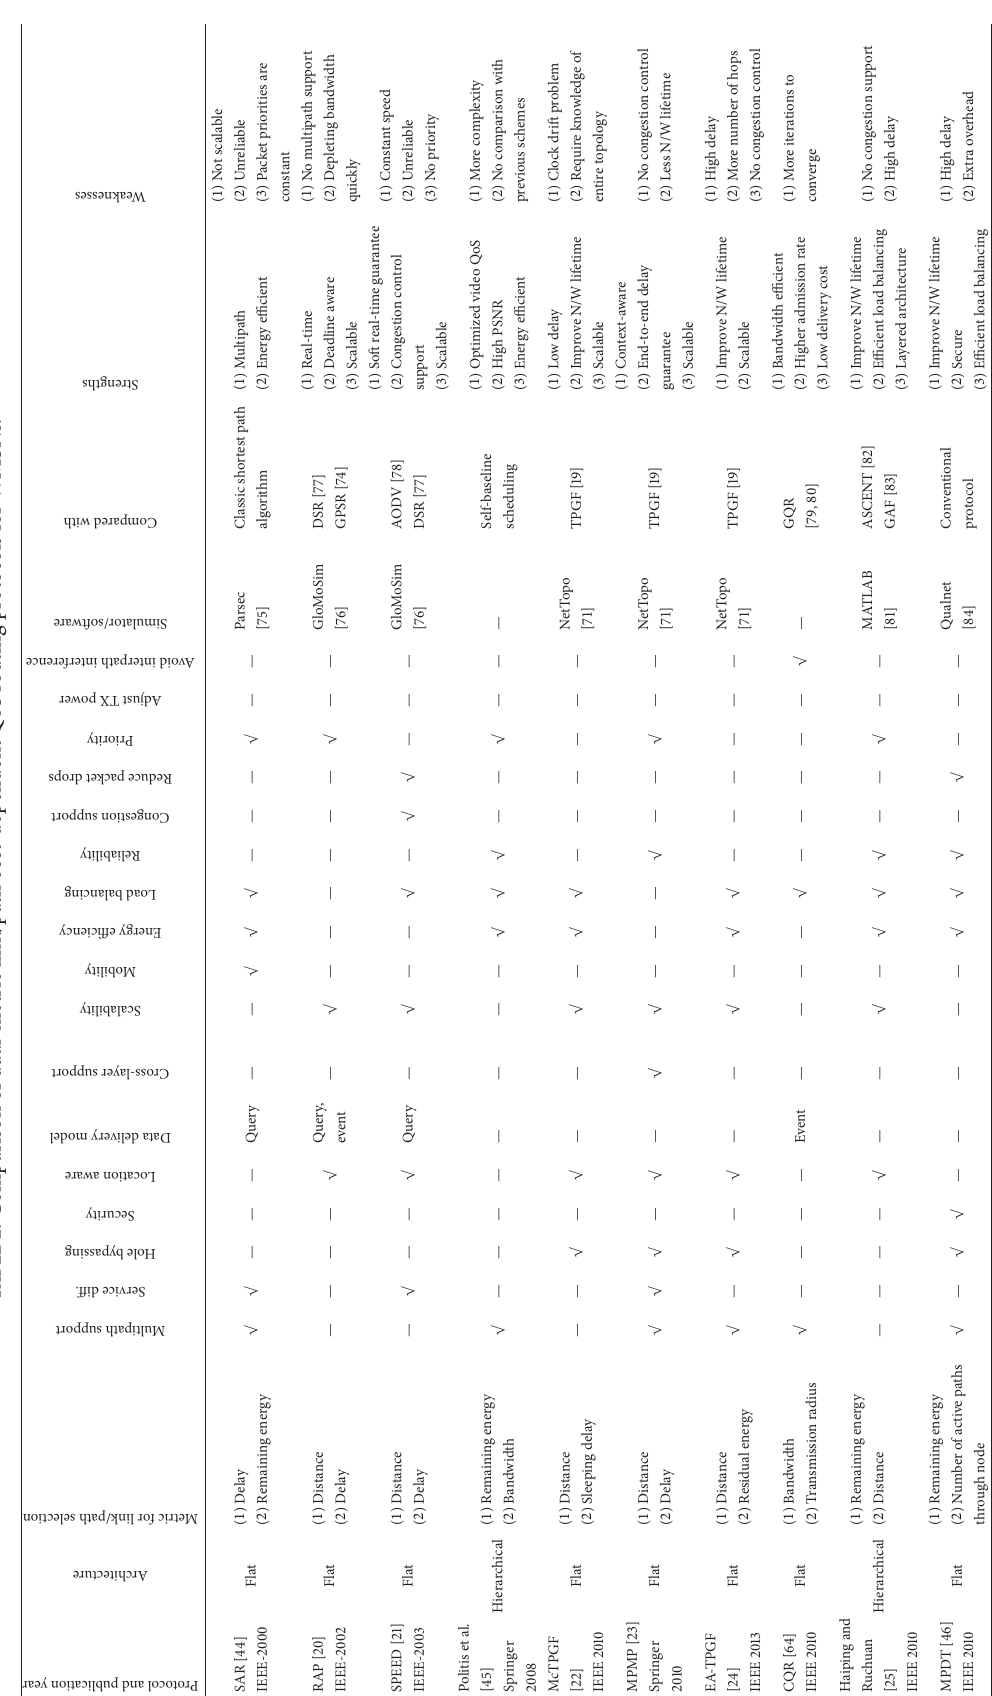
Protocolandpublicationyear